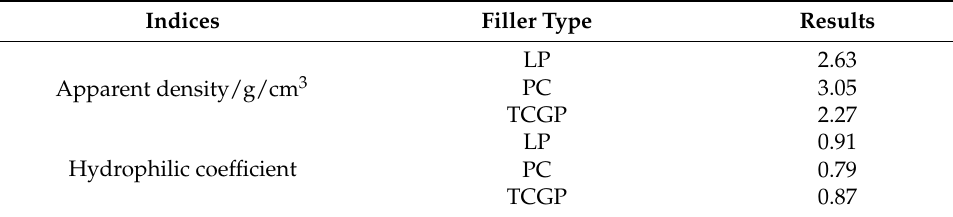
Table 4. Apparent density and hydrophilic coefficient of the fillers used in this study.